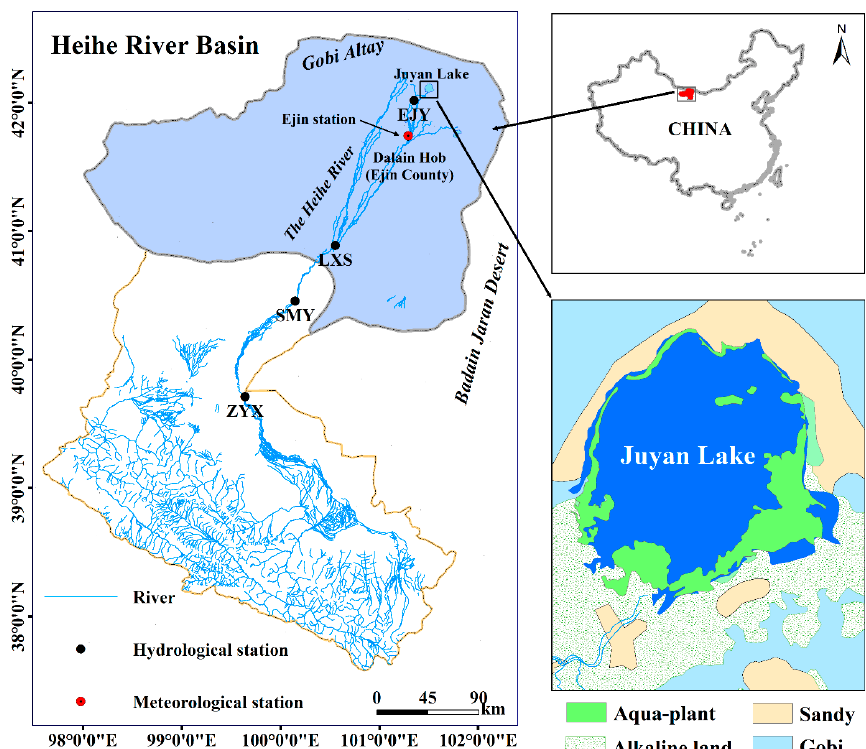
Figure 1. The schematic diagram of the Heihe River Basin, hydrological (Zhengyixia, ZYX; Shaomaying, SMY; Langxinshan, LXS; East Juyan, EJY) and meteorological station (Ejin station that located at Dalain Hob, Ejin County), the Juyan Lake and land coverage surrounding the lake.